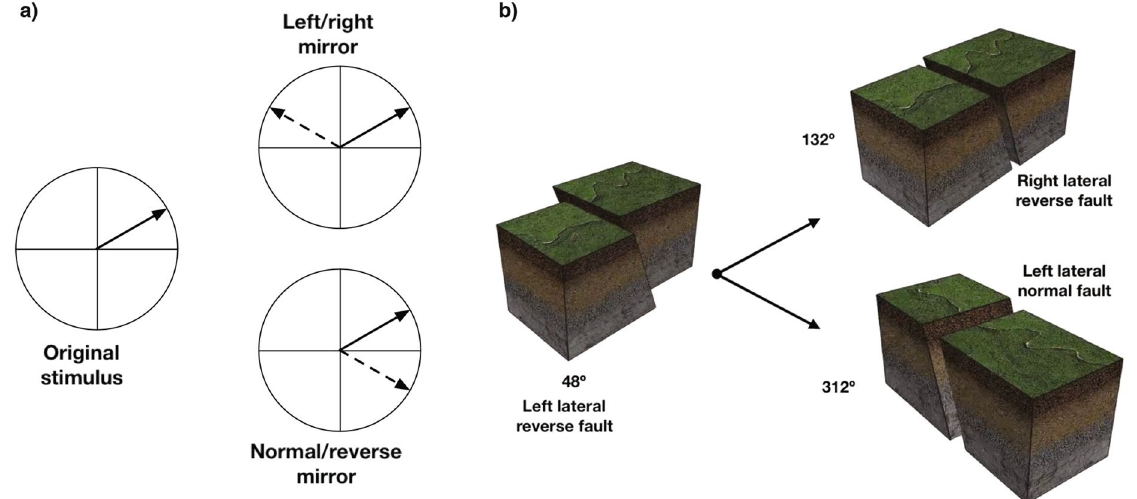
Figure 4. ( a ) Every fault defined by a particular rake angle has two corresponding “mirror images” that represent their reflection around the normal/reverse and left/right axes. ( b ) Illustration of mirror stimuli for a ◦ fault with a rake angle of 48 . (Figure generated using Adobe Illustrator 2021 and Adobe Photoshop